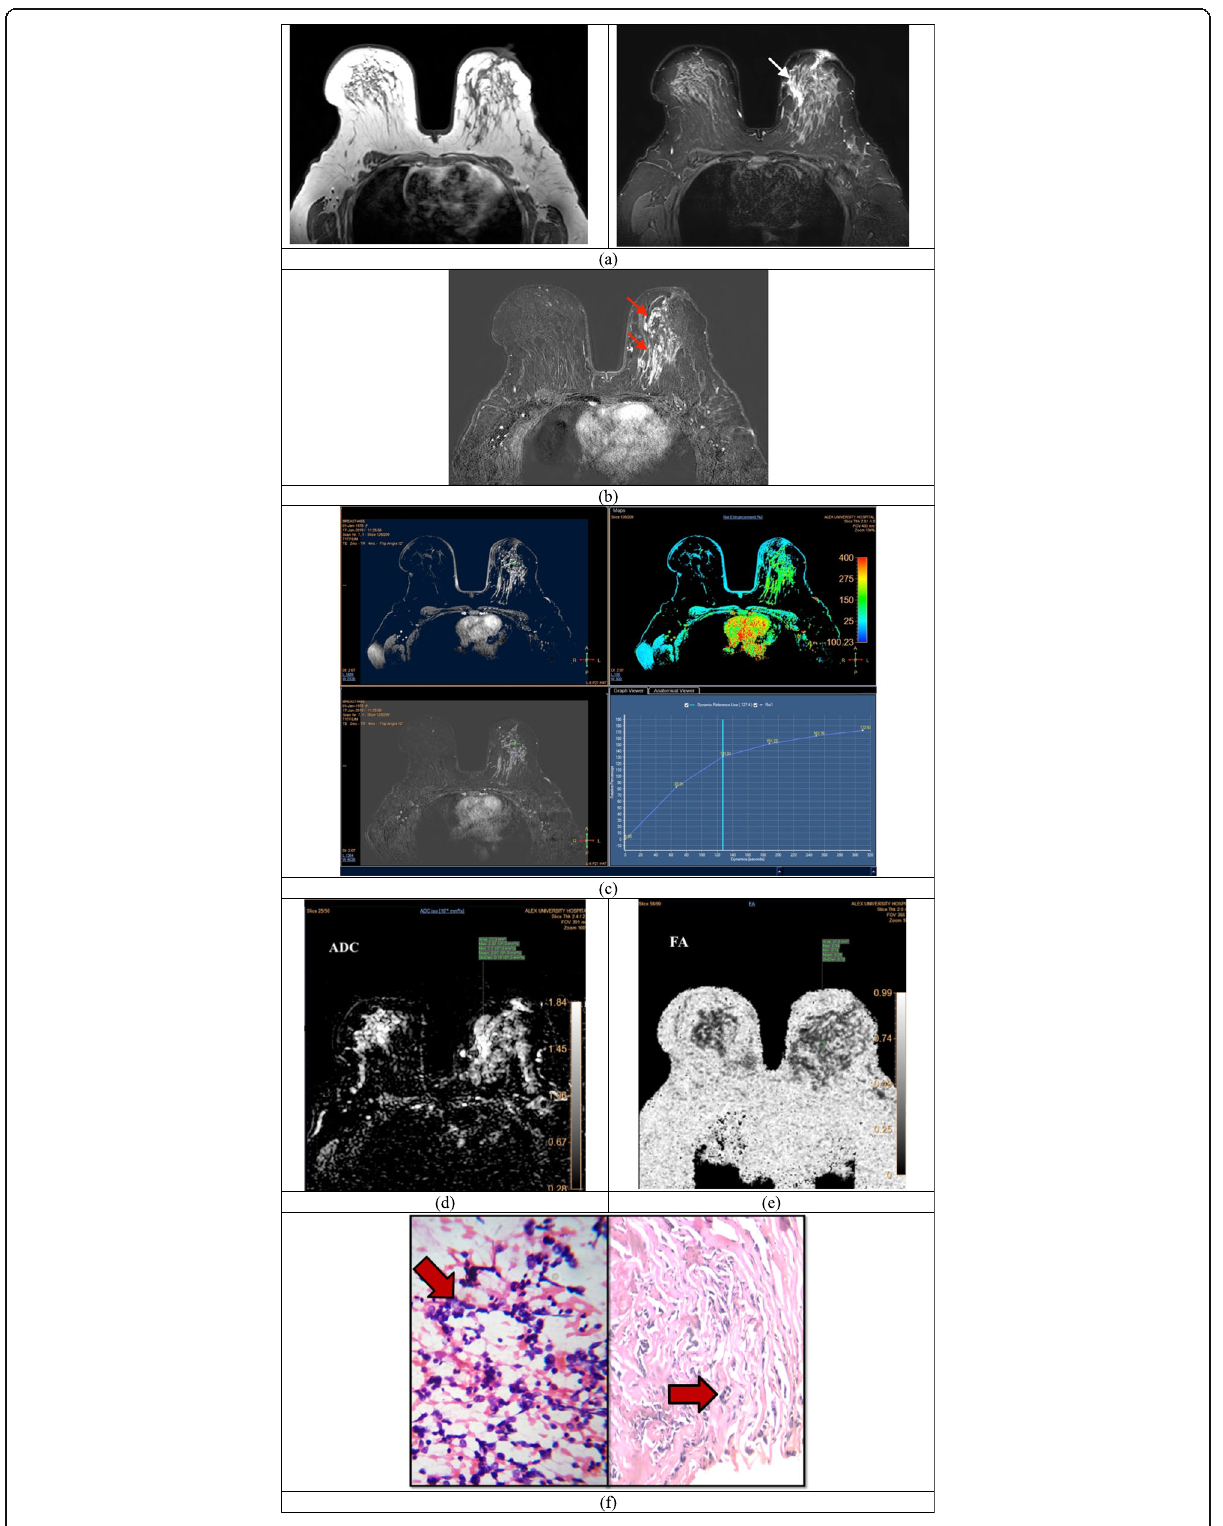
Fig. 6 (See legend on next